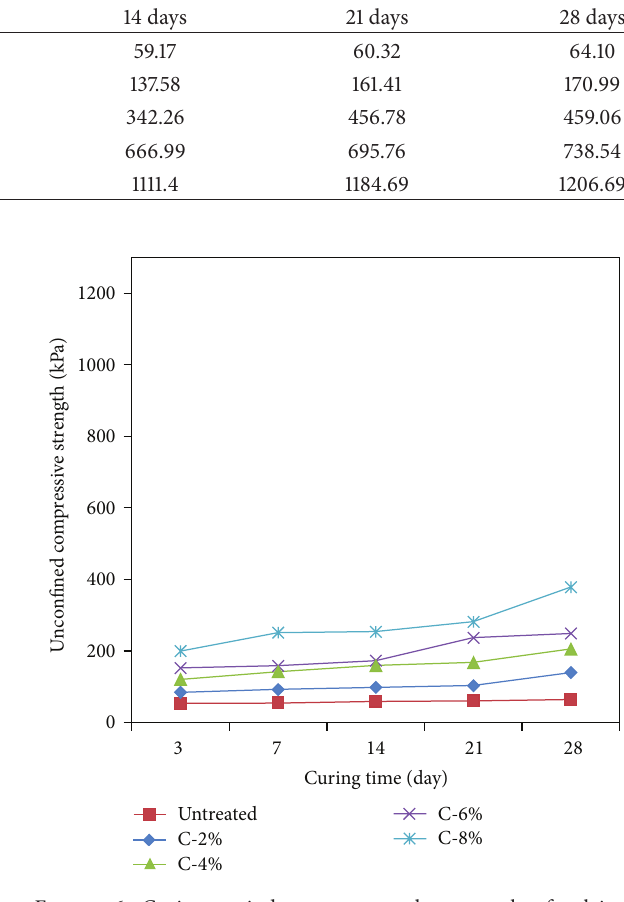
Figure 5: Curing period to compare strength of untreated speci- mens.